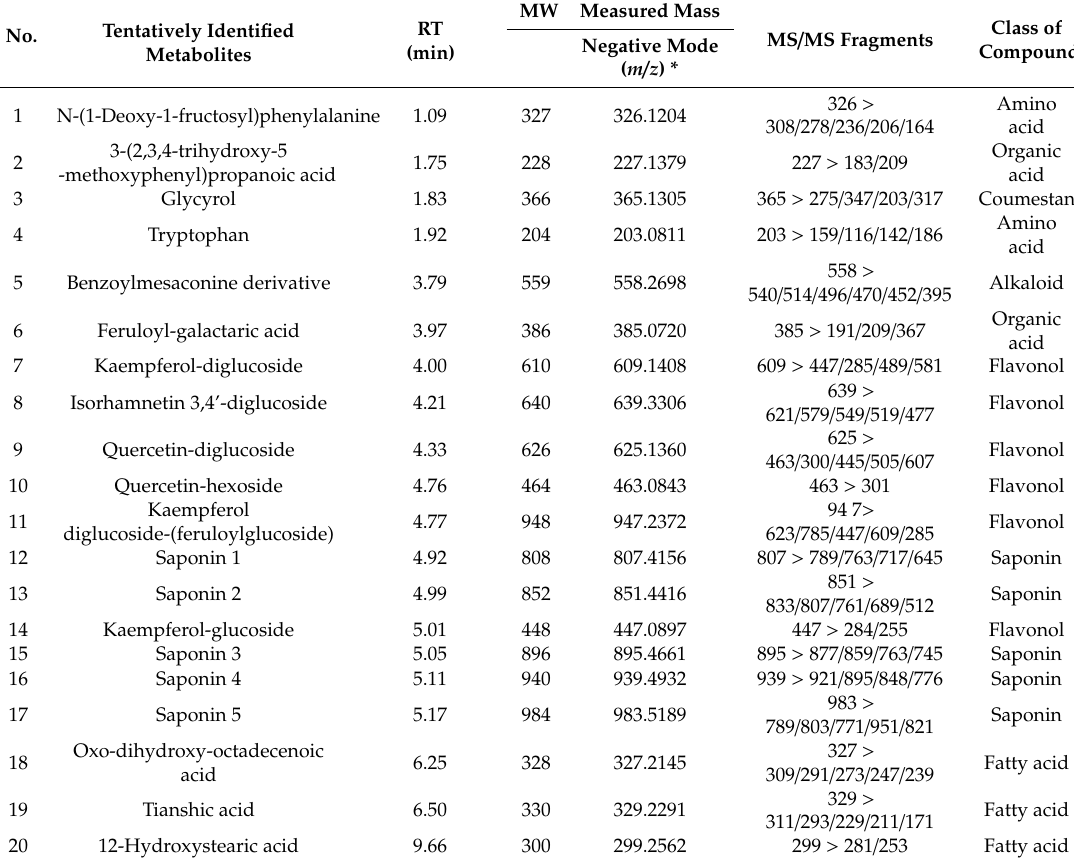
Table 2. Tentatively identified metabolites in CC juice extracts based on the UHPLC-LTQ-Orbitrap -MS / MS